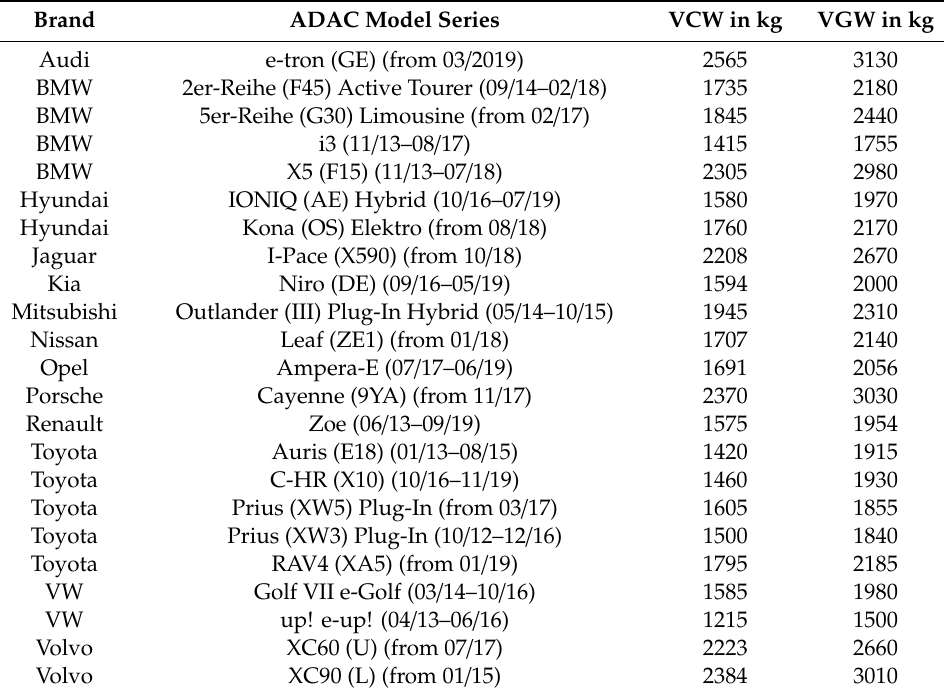
Table A5. Database for the evaluation of the wheel